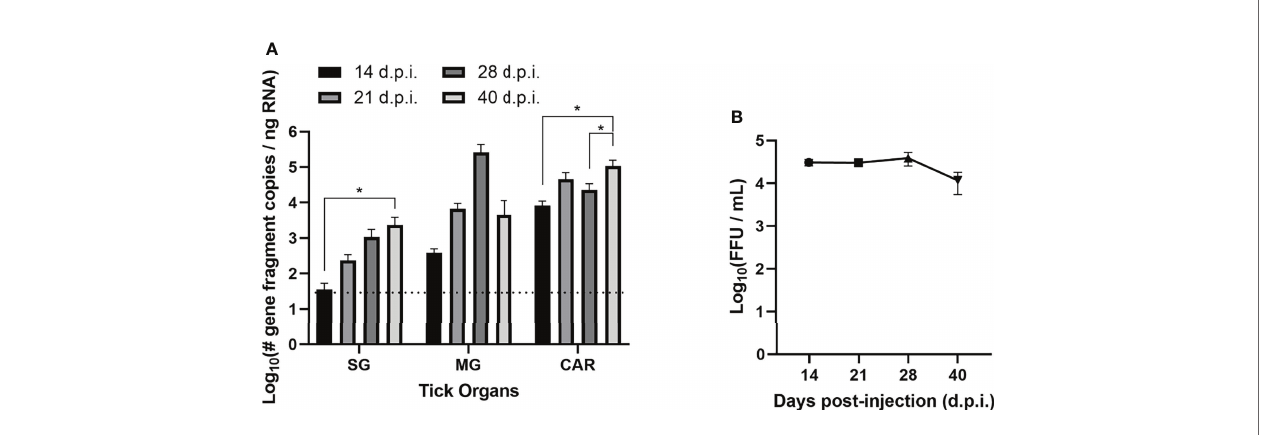
FIGURE 1 | Acquisition and maintenance of POWV by H. longicornis ticks via anal pore microinjection. (A) Detection of Powassan virus (POWV) RNA by real-time quantitative reverse transcription polymerase chain reaction (q-RT-PCR) of POWV-injected H. longicornis . Microinjected adult female ticks were dissected at 14, 21, 28, and 40 days post-injection (d.p.i.). Tick organs were screened individually: salivary glands (SG), midgut (MG), and carcass (CAR). Viral RNA quantities are expressed as the number of NS5 gene fragment copies per ng of RNA after normalization to a standard curve. The data are presented as means with error bars representing standard error of the means. Statistical signi fi cance was determined using one-way ANOVA followed by Tukey ’ s multiple comparisons test. Limit of detection ~31 gene fragment copies per ng RNA. *p < 0.05. (B) Detection of infectious POWV virions in whole microinjected ticks by focus-forming assay (FFA). Microinjected adult female ticks were collected at 14, 21, 28, and 40 d.p.i., and whole ticks were homogenized in DMEM media. Tick homogenate was cultured on Vero E6 cells, and viral titers were determined by FFA. The data are represented as the focus-forming units (FFU) per mL of POWV for each time